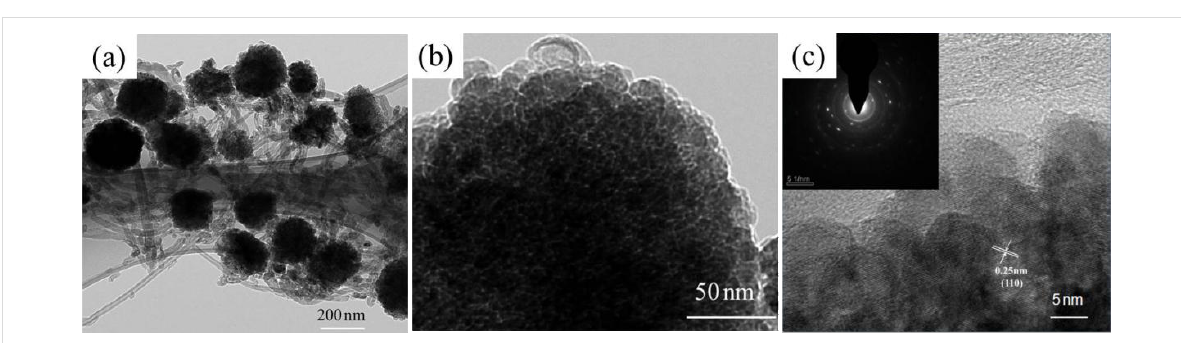
COOH-MWCNT at 500 mA·g − 1 . In the first discharge